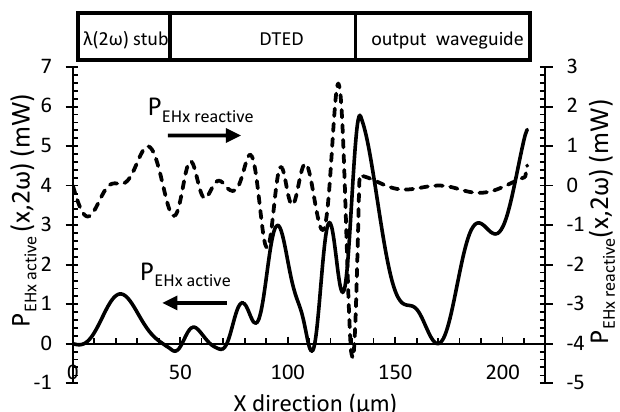
Figure 15: X direction complex EM power through S yz area at the second harmonic frequency. The DTED RF operation is intrinsically